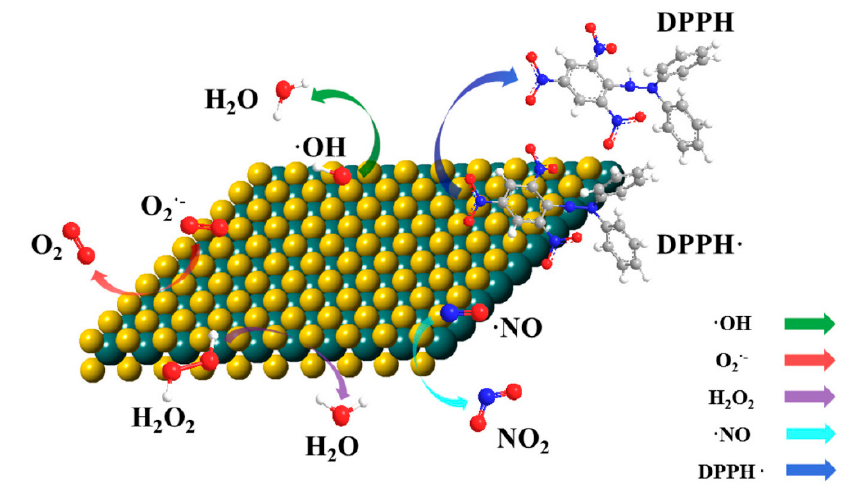
Figure 6. Illustration of the multi-fold antioxidant activity of MoS 2 nanosheets. Reprinted with permission from (Chen, T.M.; Zou, H.; Wu, X.J.; Liu, C.C.; Situ, B.; Zheng, L.; Yang, G.W. Nanozymatic